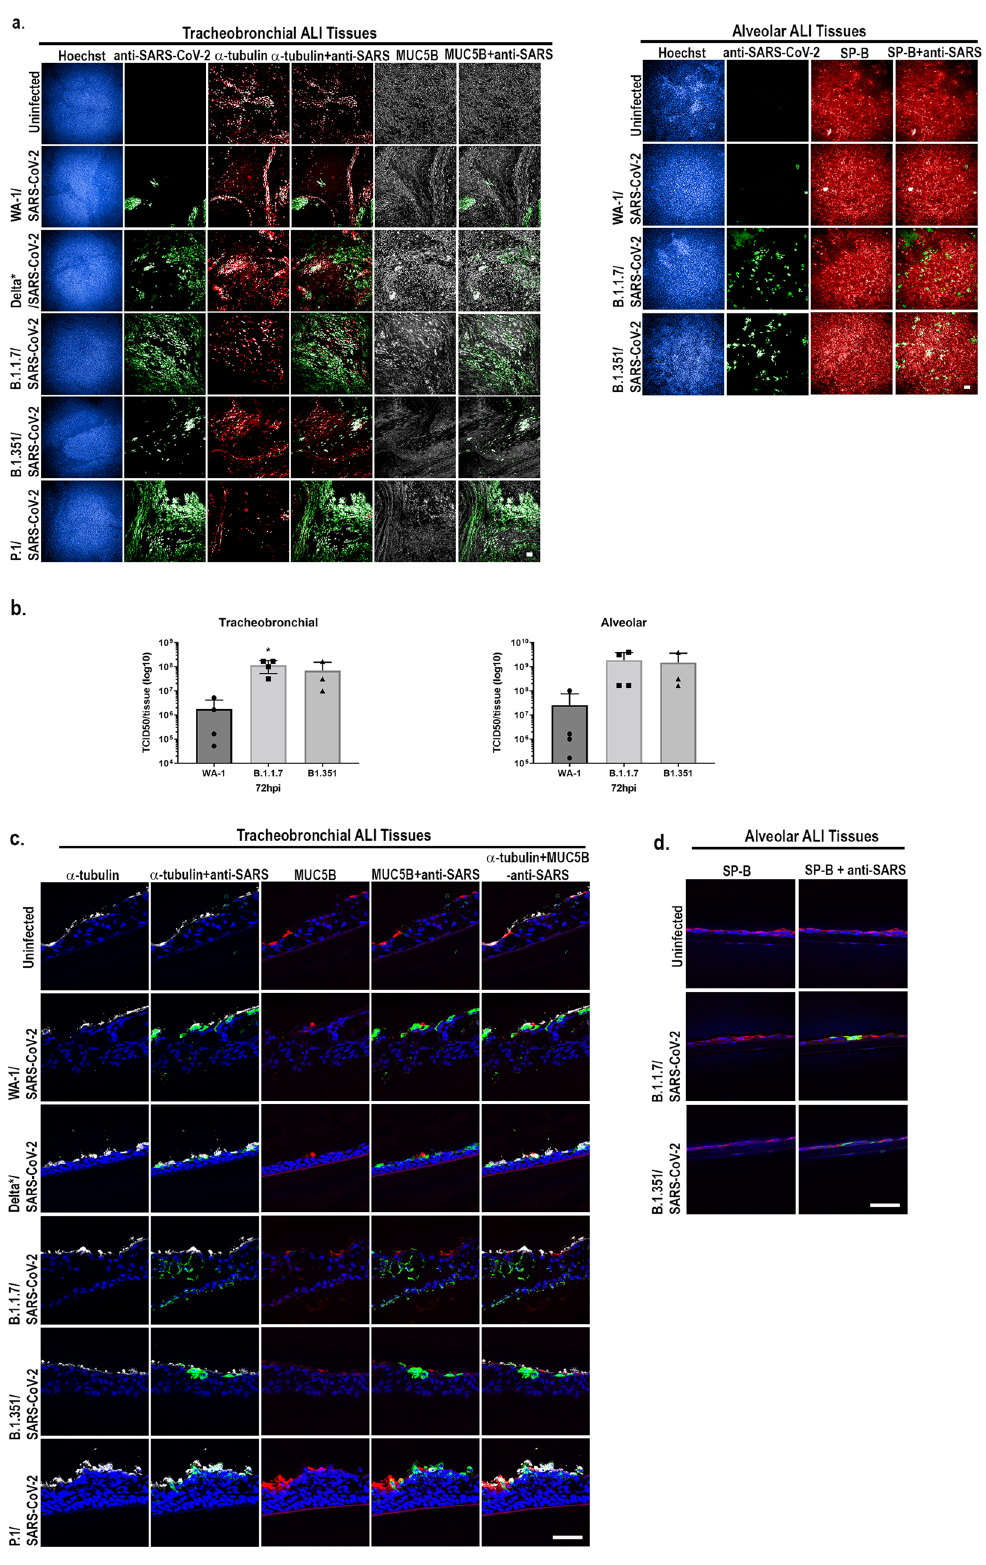
time points (Fig. 3c). Elevated chemokine levels observed are in agreement with the chemokine storm observed in severe human COVID-19 cases and different SARS-CoV-2 experimental models 56,57 , where the role of CXCL-10 has been particularly highlighted in COVID-19-associated Acute Respiratory Distress Syndrome (ARDS) as well as in severe in fl uenza 58